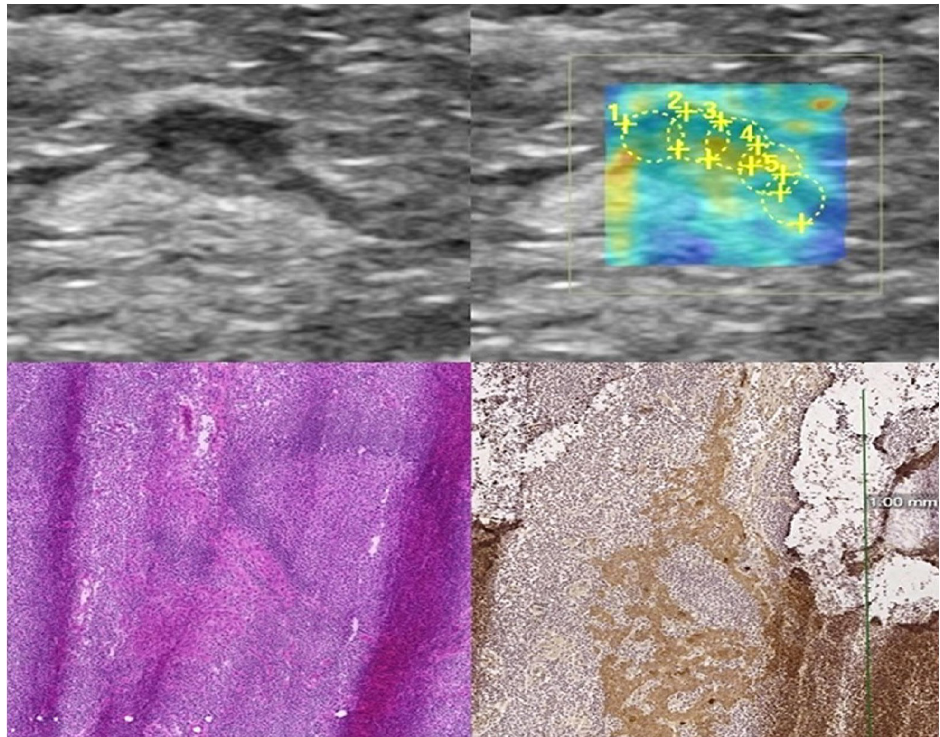
Fig 3. Ultrasound images and histopathology of a micrometastatic inguinal LN of a 67-year old woman with vulvar cancer. B-mode and elastography images (upper images) illustrate a superficial inguinal LN with abnormal focal cortical thickening. SWE demonstrated Mean-E value of 9.68 kPa and Max-E value of 11.46 kPa with 3 mm ROI in the axial plane. Histopathological analysis revealed a micrometastatic 1 mm deposit of squamocellular carcinoma. HE and cytokeratin stainings are illustrated in the lower row. atypical nuclei show variation in their size and shape. Additionally metastatic cell nuclei stain positive (brown) in cytokeratin staining (scale bar 1 mm).